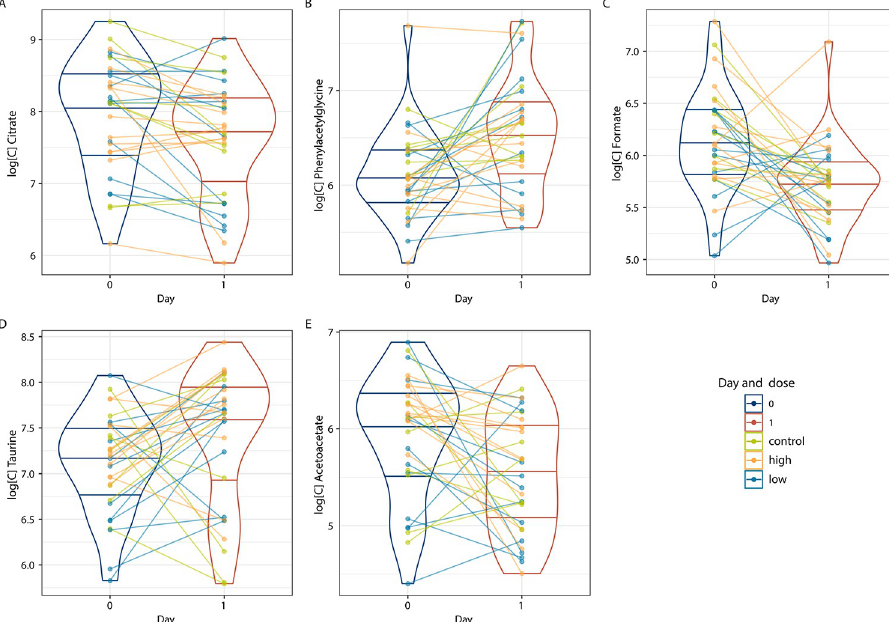
Fig 4. Metabolites that changed at day 1 post vaccination. A, B, C, D and E show plots of metabolites that changed significantly at day 1 post vaccination. Y axis corresponds to metabolite log transformed concentration and X axis to timepoint. Dot and line are colored according to vaccine type (control = Hepatitis B, low = low dose HOOKVAC and high = high dose of HOOKVAC). Horizontal lines indicate 0.25, 0.50, 0.75 quantiles. HOOKVAC: Hookworm vaccine candidates comprising of Na-GST-1 and Na-APR-1